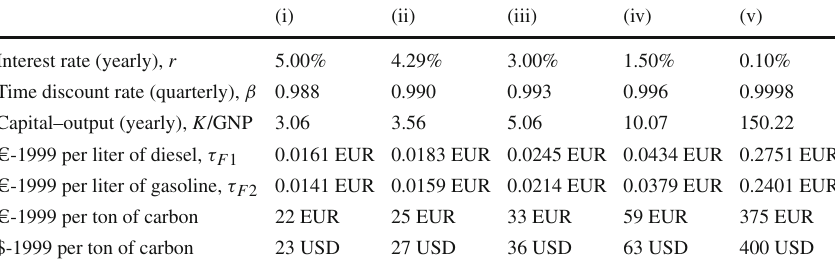
Table 6 Pigouvian taxation on fuel and